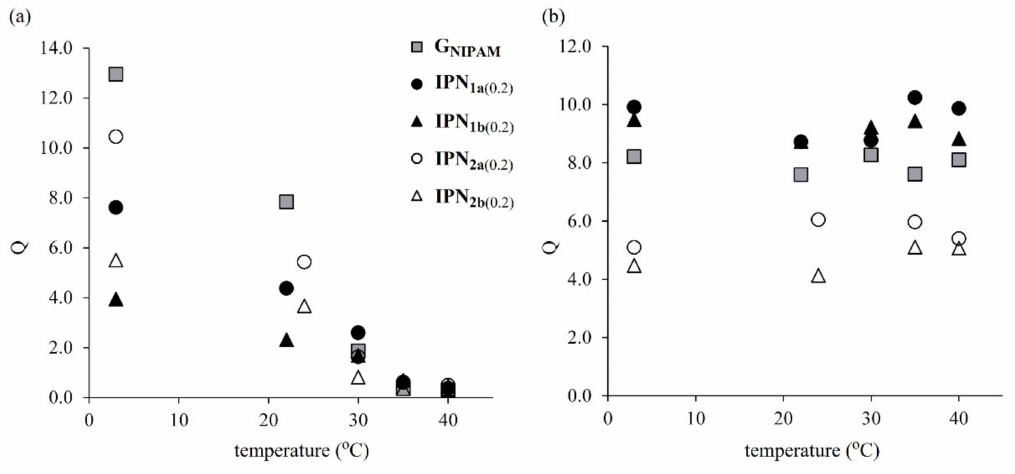
Figure 4. Plots of swelling degree ( Q ) of G NIPAM (Table 2, run 1) ( (cid:4) ), IPN 1a(0.2) (run 3) ( • ), IPN 1b(0.2) (run 6) ( (cid:78) ), IPN 2a(0.2) (run 8) ( ), and IPN 2b(0.2) (run 10) ( (cid:52) ) ( a ) in water and ( b ) in N,N -dimethylformamide (cid:35)